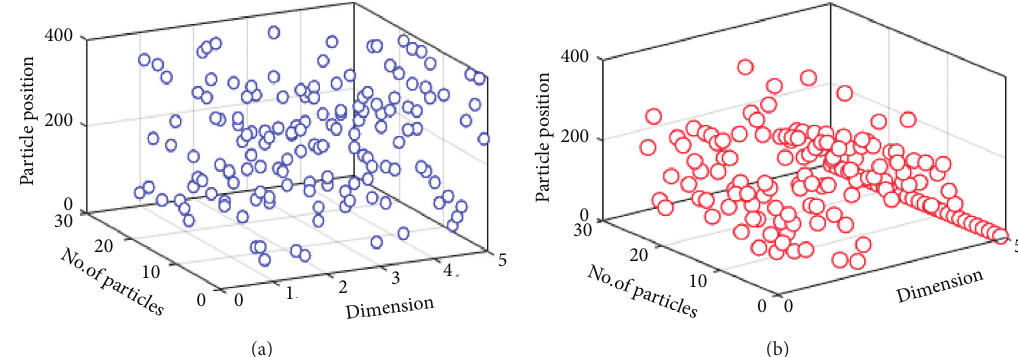
Figure 10: Random Initialization of particles. (a) PSO. (b) AIWPSO.